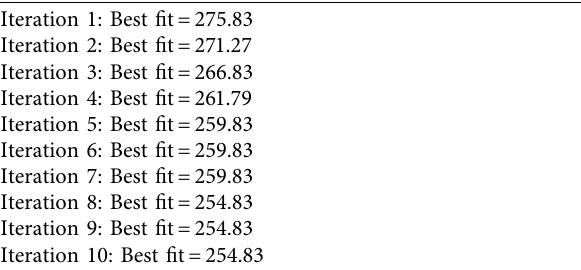
Table 11: Results of objective functions in the ten iterations.